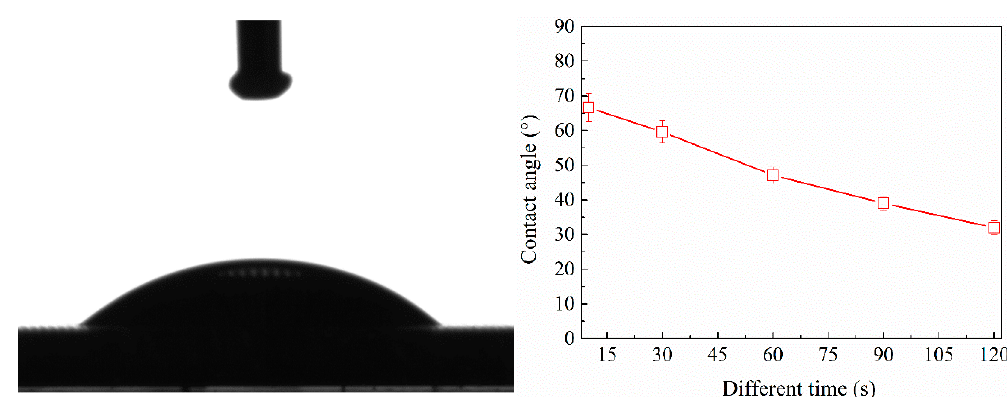
Figure 7. Static contact angle of PSVBA-grafted textured surface at different times ( a – c ), and its evolution with time increased ( d ) under saturated NaCl solution conditions.